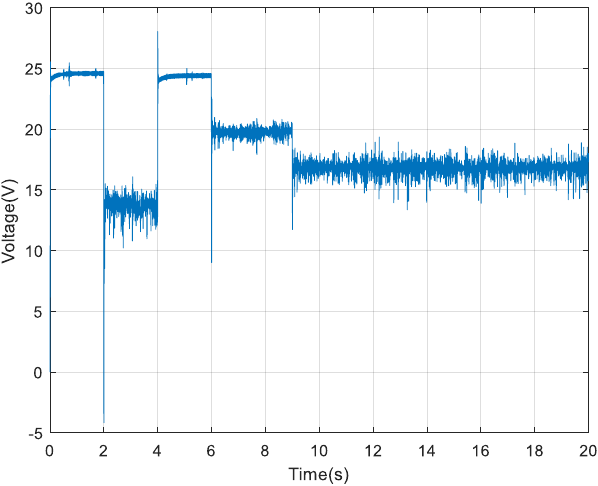
Figure 20. Temporal evolution of the motor voltage.